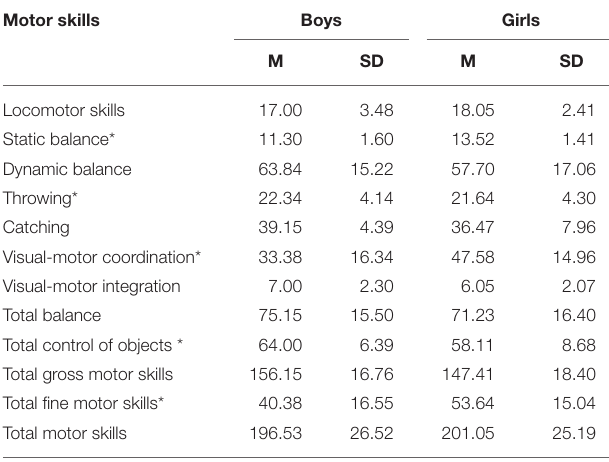
TABLE 4 | Means (M) and Standard Deviations (SD) of motor skills scores according to